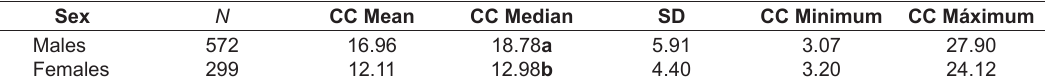
Table 3. Descriptive measures for males and females of Aegla manuinflata in the Passo Taquara Stream, São Pedro do Sul, Rio Grande do Sul state,